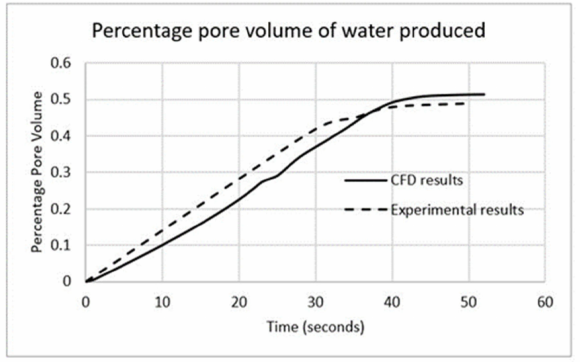
Figure 6. CFD versus experimental results—validation simulation.